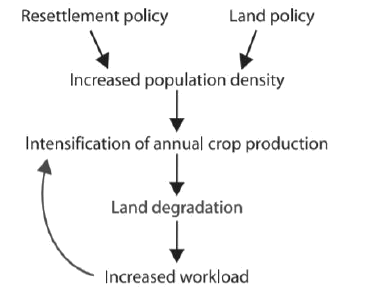
Figure 2. Flowchart of